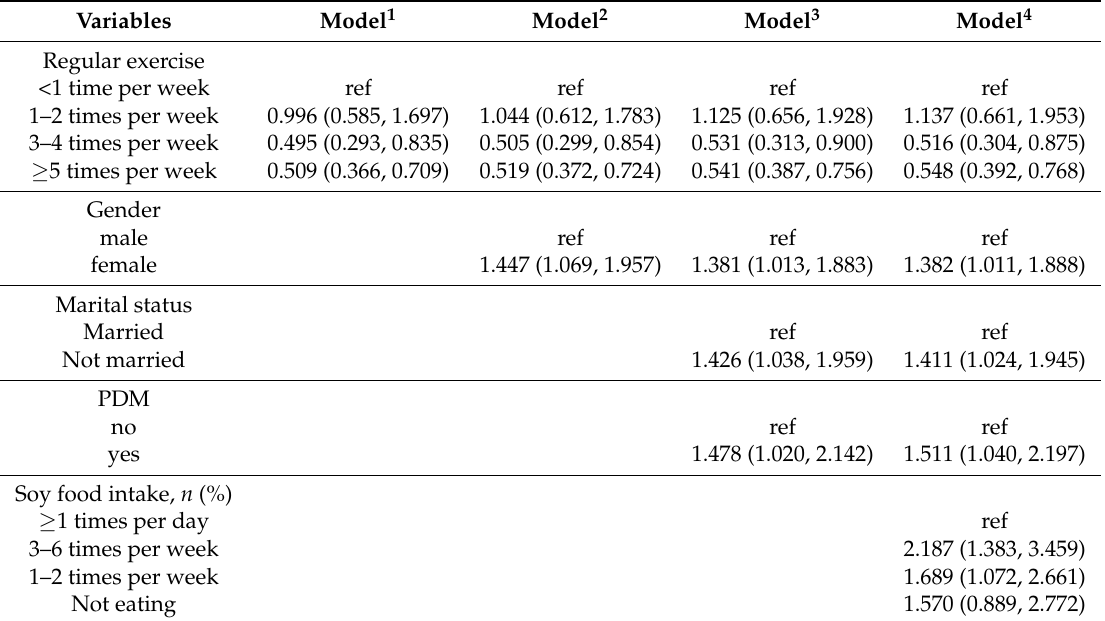
Table 3. Odd ratios (ORs) and their 95% confidence intervals (CI) of the risk of physical exercise for depression from ordered logistic